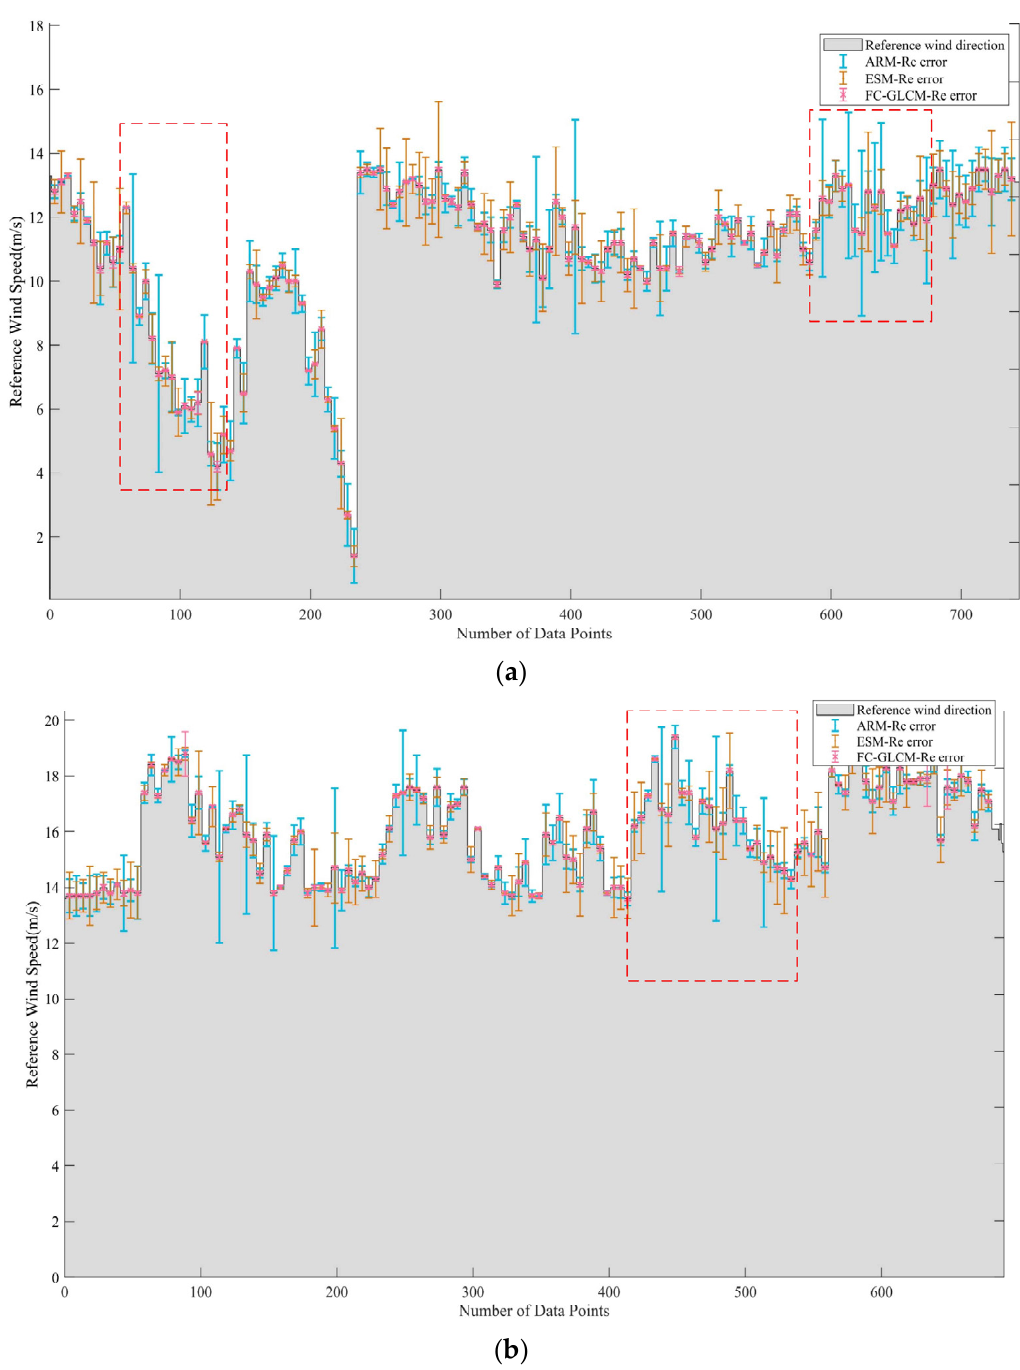
Figure 15. Wind direction error between estimated direction and reference wind direction at different wind speeds. (The shaded area represents measurement speed data by vane and the red dotted box represents the area with large fluctuations in the error range.) ( a ) Wind direction error between retrieved direction and reference wind direction when the wind speed is 0–13 m/s. ( b ) Wind direction error between retrieved direction and reference wind direction when the wind speed is 13–20 m/s.